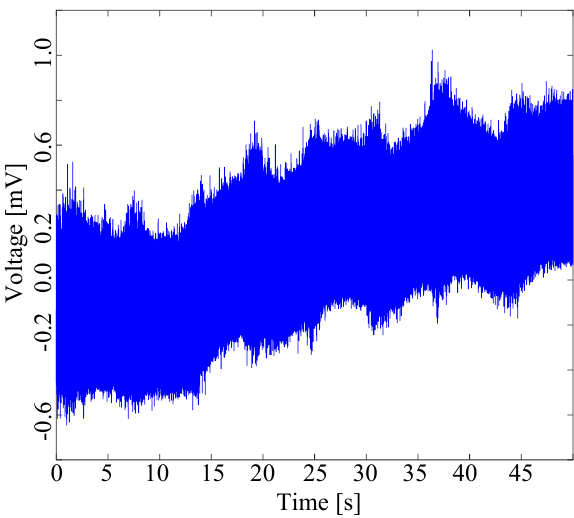
Fig. 5. Comparison of the signal from one thermocouple (blue) and two differentially connected thermostats where one is on the zero-point thermostat (red).